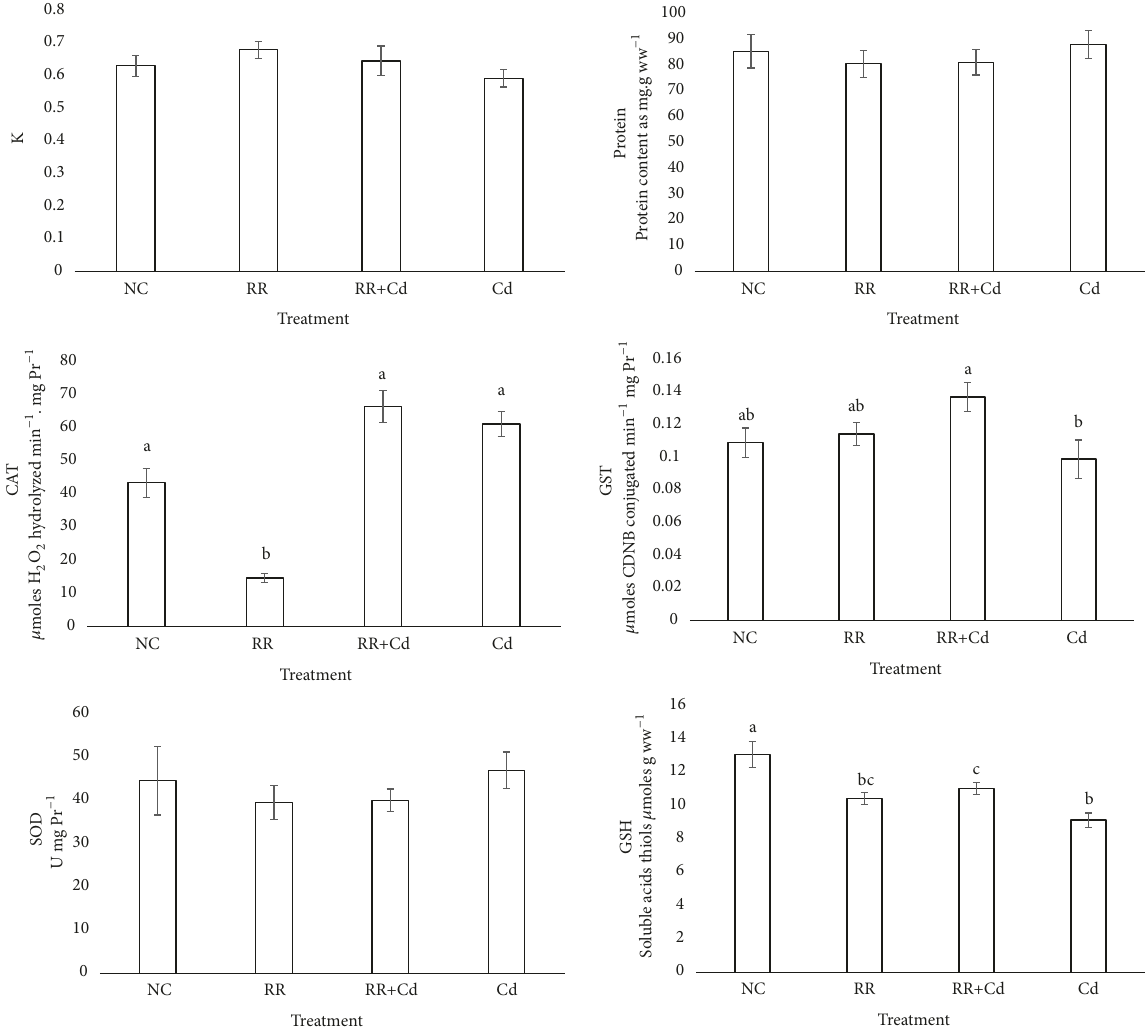
Figure 6: Biomarkers and morphological parameters of oxidative stress in Cnesterodon decemmaculatus exposed to different treatments for 96 hs. Treatments:NC (negativecontrol,MHW);RR (surfacewaterof theReconquista River); RR+Cd (surface waterof the Reconquista River with 2 mg Cd/L); Cd (2 mg Cd/L). Values are expressed as mean ± SEM. Treatments not sharing a common letter are statistically different from each other (ANOVA followed by Tuckey test, p < 0.05). Number of individuals analyzed in each treatment: